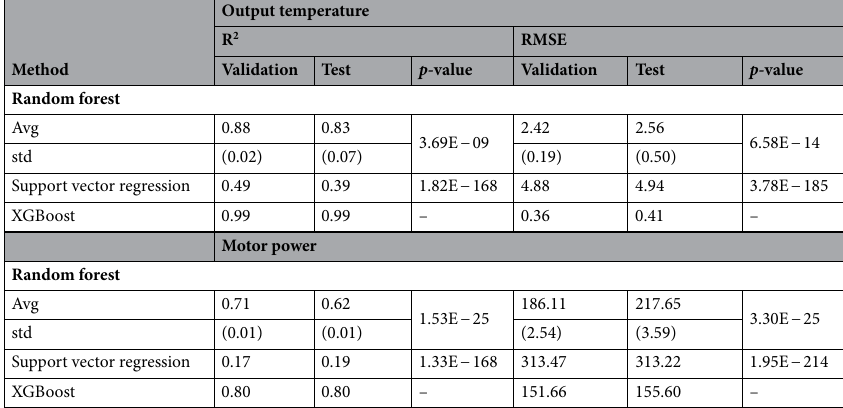
Table 3. Outcomes of various models in the validation and testing stages.